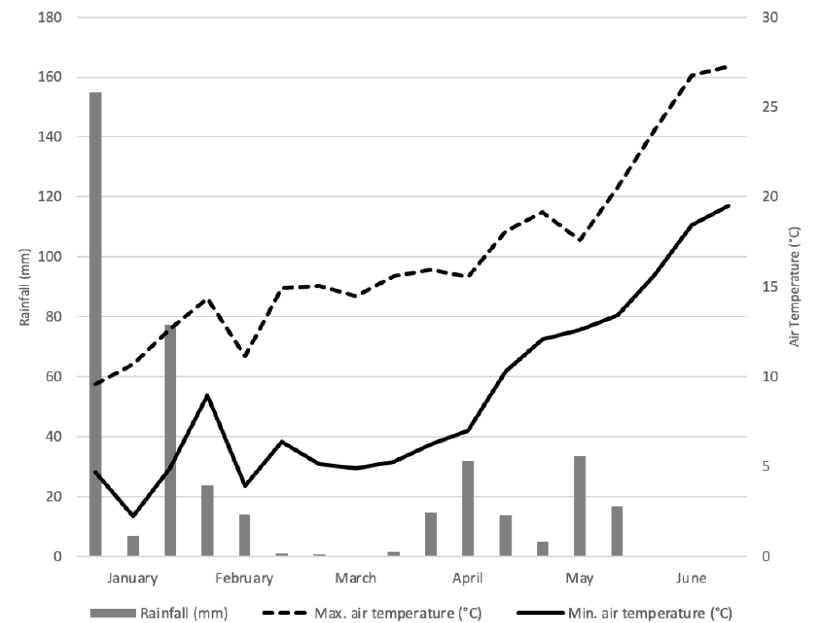
Figure 1. Cumulative precipitations and maximum and minimum average temperatures recorded by the meteorological station in Bocca d’Arno (Pisa, Italy) ( 43°40 ′ 51.6 ″ N, 10°16 ′ 48.0 ″ E). Major weeds present in the field were: the monocotyledons Cyperus rotundus L., Cynodon dactylon L. Pers., and Poa annua L., and the eudicotyledons Convolvulus arvensis L., Anagallis arvensis L., and Veronica persica Poir.